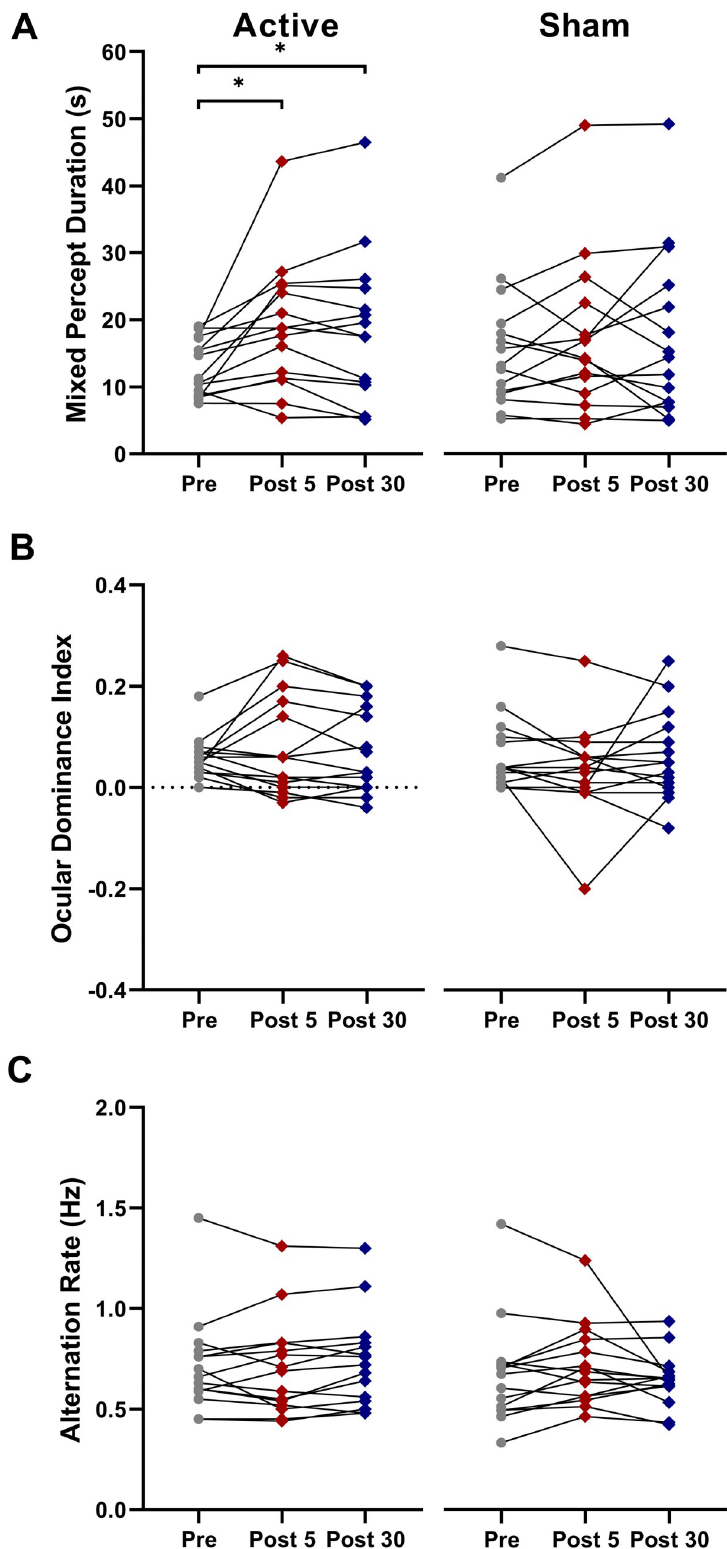
Fig 3. Average time spent in mixed percept (A), ocular dominance indices (B), and alternation rates (C) for 15 participants pre-stimulation, 5 minutes and 30 minutes post cTBS. Error bars = SEM. � p < 0.05.